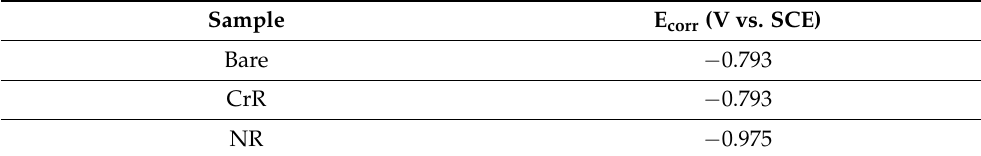
Table 4. E corr value recorded before the potentiodynamic-polarisation